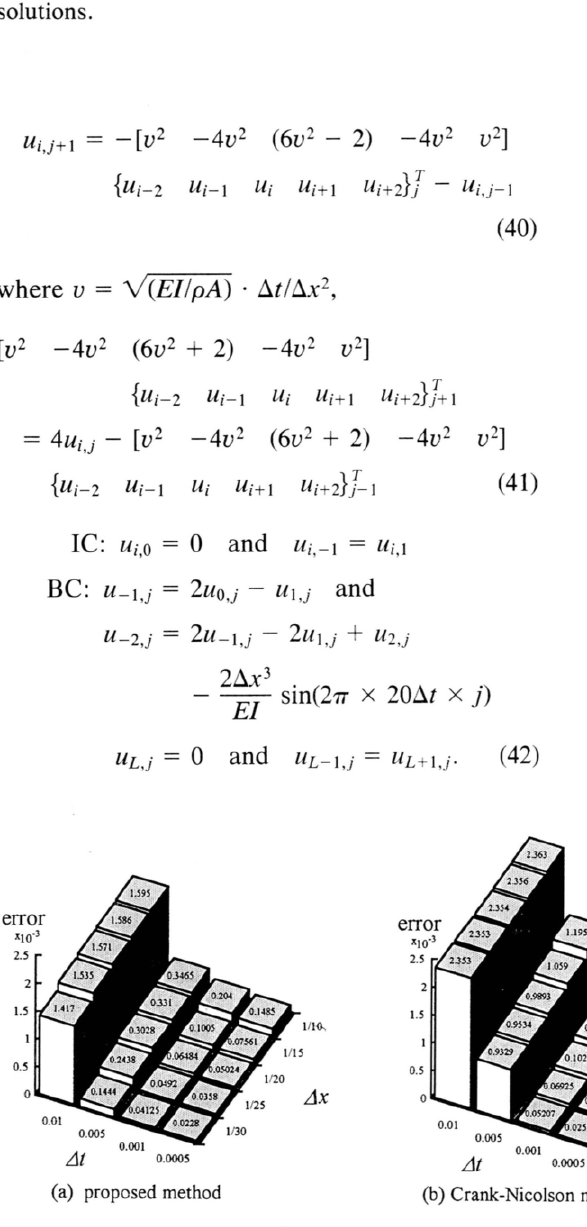
FIGURE 9 Comparison of the error of each numerical method as varying ~x and M